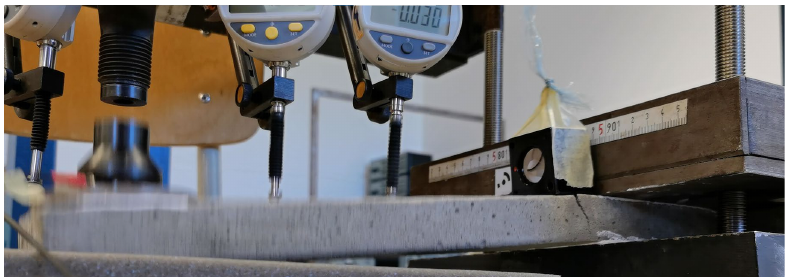
Figure 11. Collapse of the CC specimen 5200420.